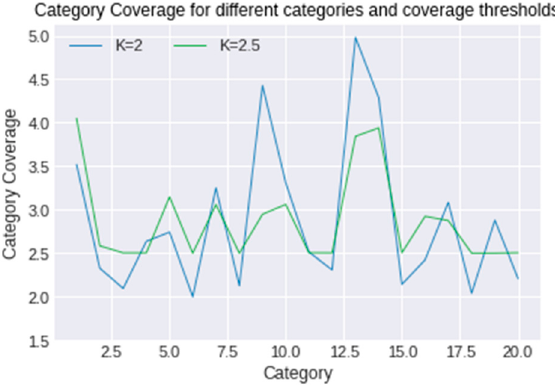
Figure 2. Coverage per provider for K = 2 and K = 2.5.